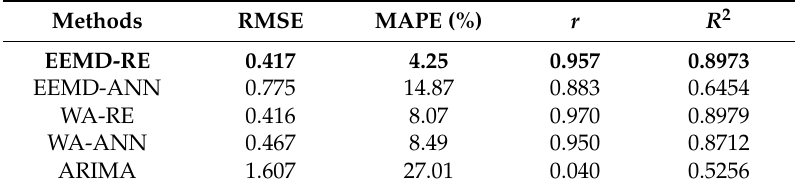
Table 3. Predictive accuracy of statistical results using daily data with 1 month interval.